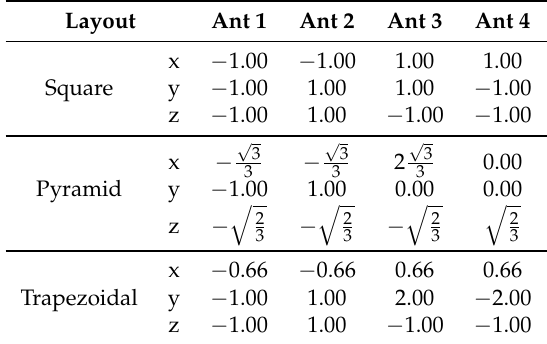
Figure 2. Representation of the positions of the antennas represented as black dots, in a Cartesian coordinate system. Ant stands for antenna. Table 1. Antenna positions (m) for the three configurations in the